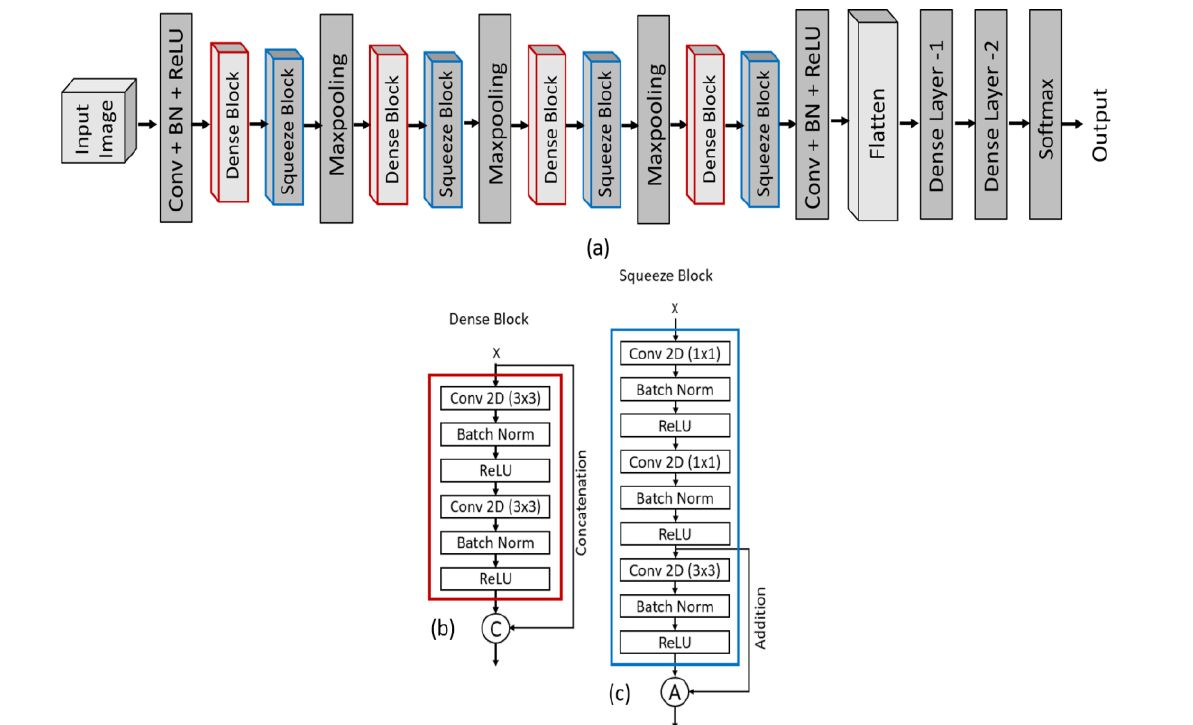
Figure 3. The entire architecture of the proposed DCSCNN model. ( a ) Design of convolution neural network with two fully connected layers. ( b ) Dense block with concatenation function. ( c ) Squeeze block with additional function. In dense block, the term “x” is the input layer of Convolution, Batch normalization, and ReLU, while in squeeze block, the term “x” is the output of the dense block.